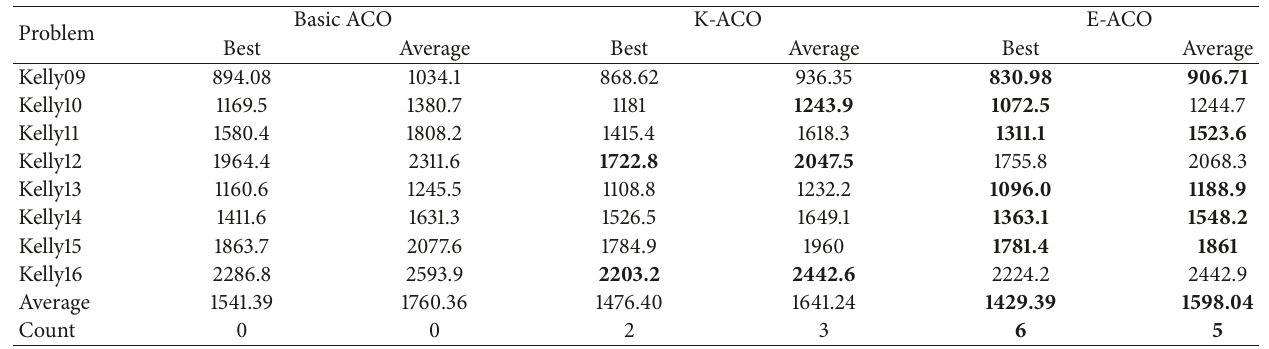
Table 5: Comparison of basic ACO, K-ACO, and E-ACO.